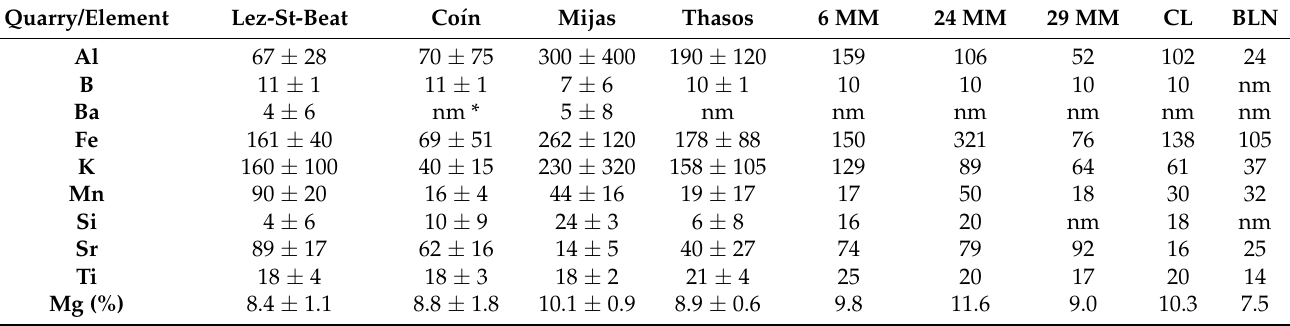
Table 3. Elemental analysis of dolomitic marbles from the different quarries studied. Values are expressed ± standard deviation in ppm, except for Mg (%, w/w ). * nm: not measurable (value under the threshold, 5–10